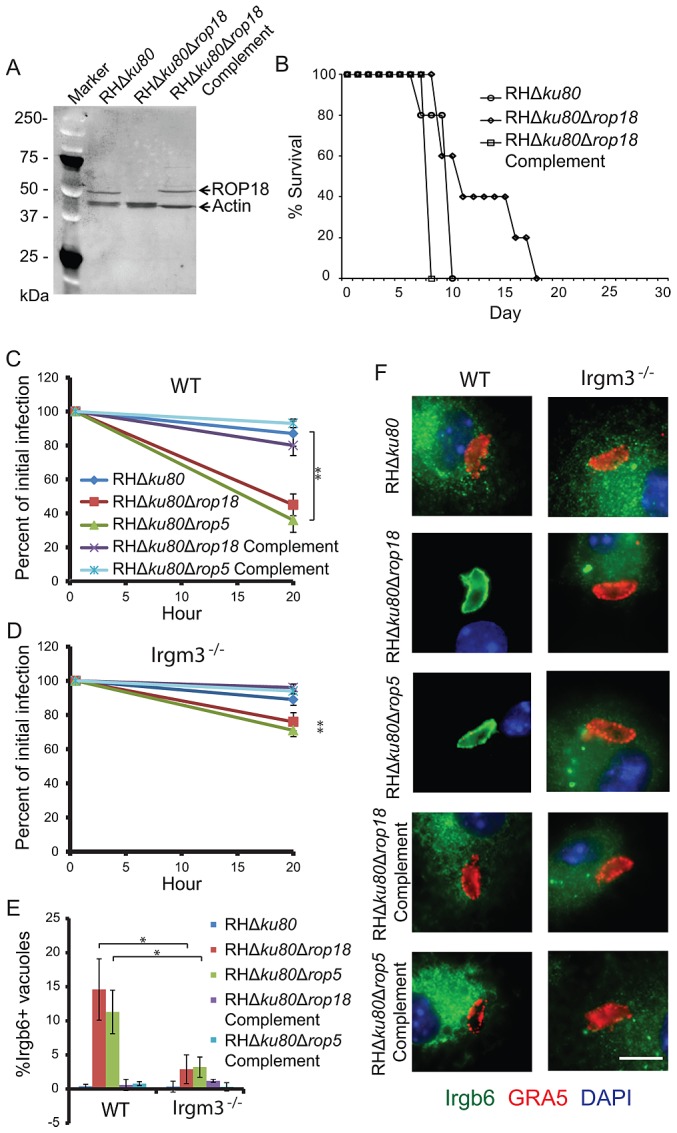
Irgm3 deficiency reverts the IRG recruitment and clearance defects of both Δrop18 and Δrop5 parasites in vitro.(A) Western blot analysis of wild type (RHΔku80), ROP18 deficient (RHΔku80Δrop18) and ROP18 complemented (RHΔku80Δrop18Complement) parasites. Western blot probed with rabbit anti-ROP18 and rabbit anti-actin flowed by goat anti-rabbit conjugated to HRP and detected by ECL. (B) Survival of female outbred CD1 mice challenged with 100 parasites by i.p. inoculation. n = 5 animals per group from a single experiment. In vitro clearance of parasites in wild type C57BL/6 (WT) (C) or Irgm3 deficient (Irgm3−/−) (D) bone marrow derived macrophages following IFN-γ activation (50 units/mL). Means ± S.D. n = 6 samples from 2 combined experiments. For statistical analysis, parasite survival in Irgm3 deficient cells was compared to survival in wild-type cells. Student's t test, **P<0.001. Quantification (E) and immunofluorescence localization (F) of Irgb6 localization to the vacuolar membrane in WT or Irgm3−/− IFN-γ-activated macrophages. (E) Means ± S.D. n = 6 samples from 2 combined experiments. Student's t test, *P<0.005. (F) The vacuole membrane was visualized by staining with mAb Tg 17-113 for GRA5 (secondary: Alexa Fluor 594, red). Irgb6 was visualized with rabbit-Irgb6 (secondary: Alexa Fluor 488, green). Scale = 5 microns.